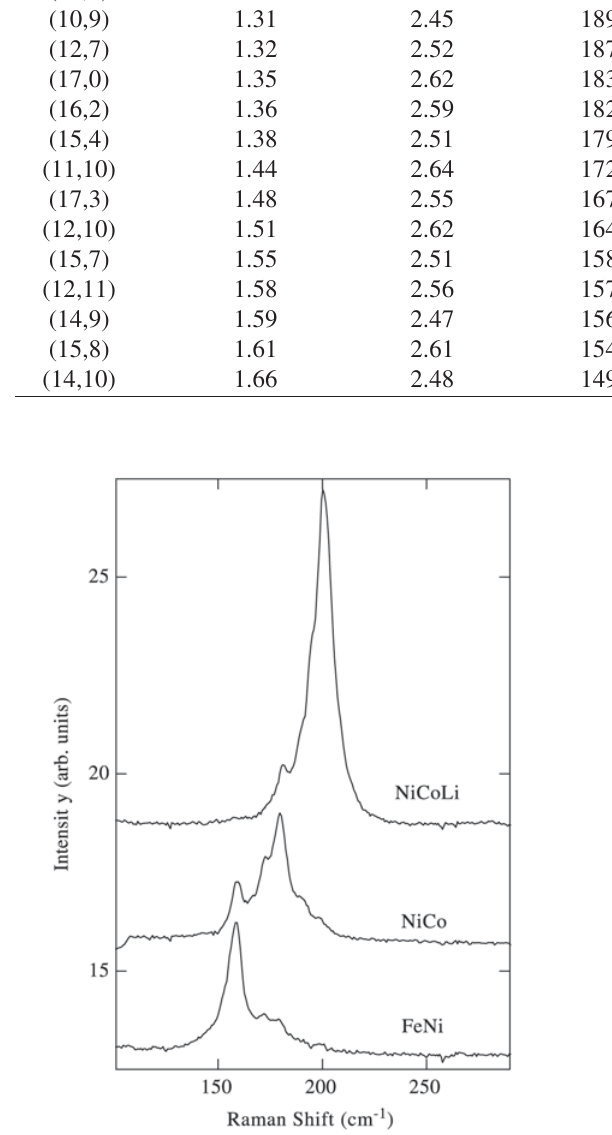
Figure 3. Raman spectra from three different SWCNTs samples in the radial breathing mode frequency range.